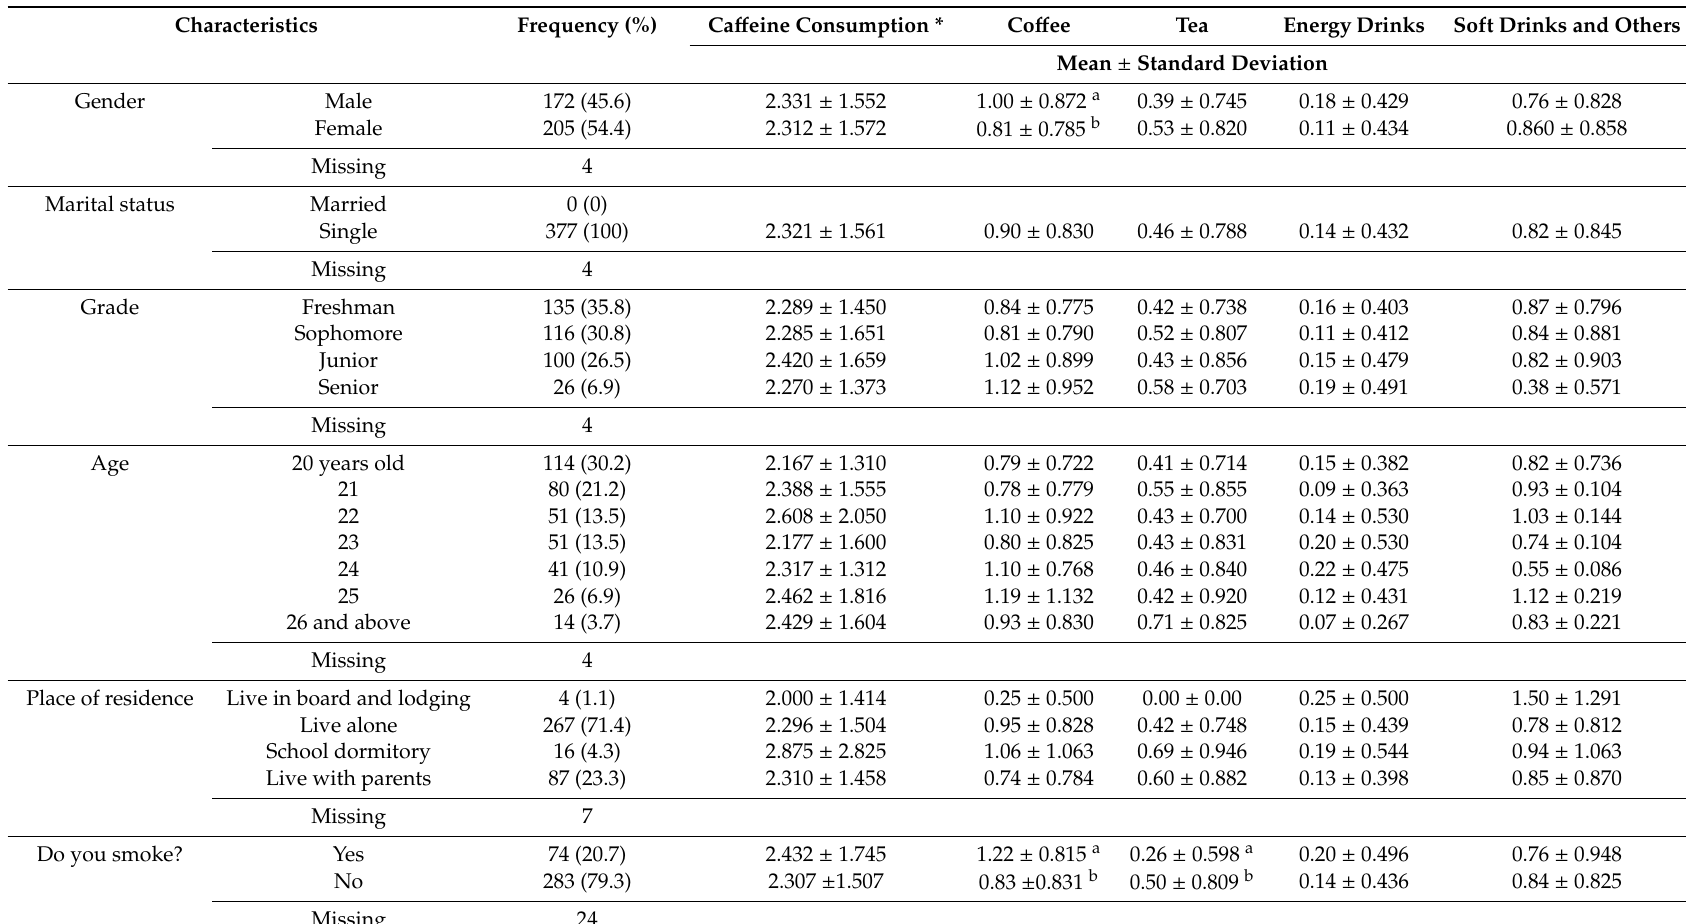
Table 1. Demographic characteristics and ca ff einated beverage consumption behaviors ( n =